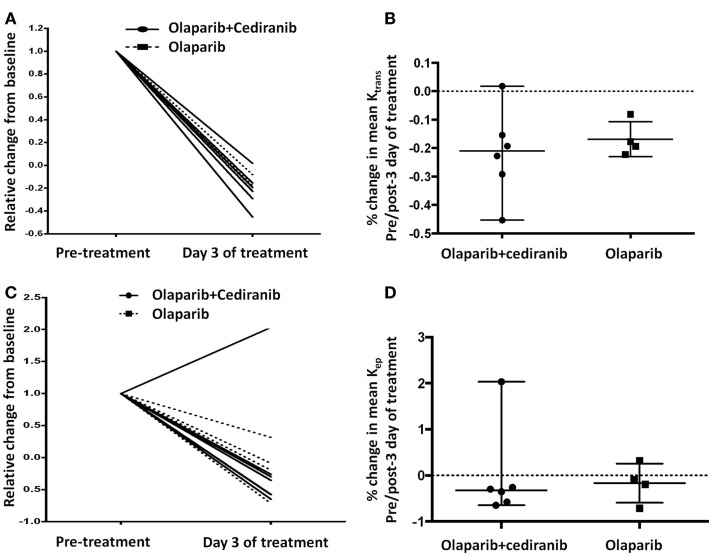
DCE-MRI. (A,B) All patients had reduction of Ktrans without statistically significant differences between arms (p = 0.61). Solid line represents patients treated with olaparib/cediranib and dot line represents patients treated with olaparib alone. (C,D) All but one patient had reduction of Kep after treatment without significant difference between arms (p = 0.61). Solid line represents patients treated with olaparib/cediranib and dotted line represents patients treated with olaparib alone.